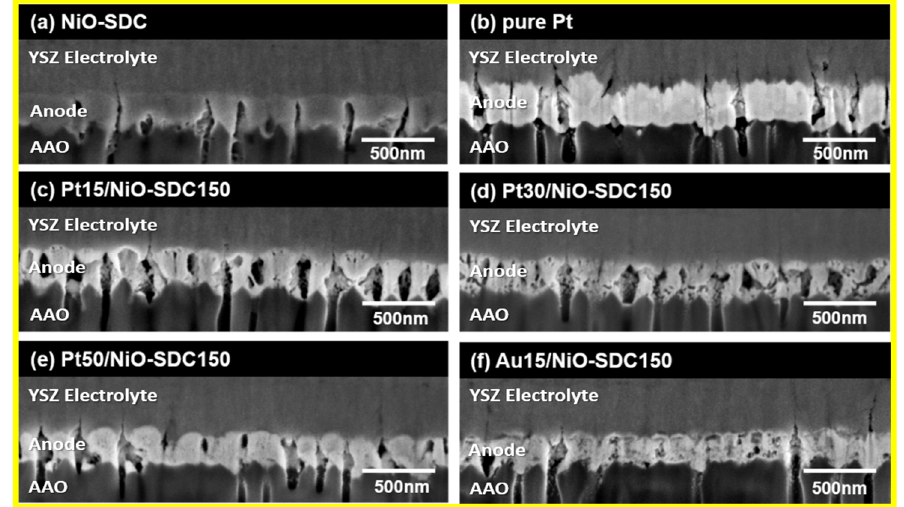
Figure 3. Cross-sectional structures of the anodes ( a ) NiO-SDC, ( b ) pure Pt, ( c ) Pt15 / NiO-SDC150, ( d ) Pt30 / NiO-SDC150, ( e ) Pt50 / NiO-SDC150, and ( f ) Au15 / NiO-SDC150 on the AAO substrate.